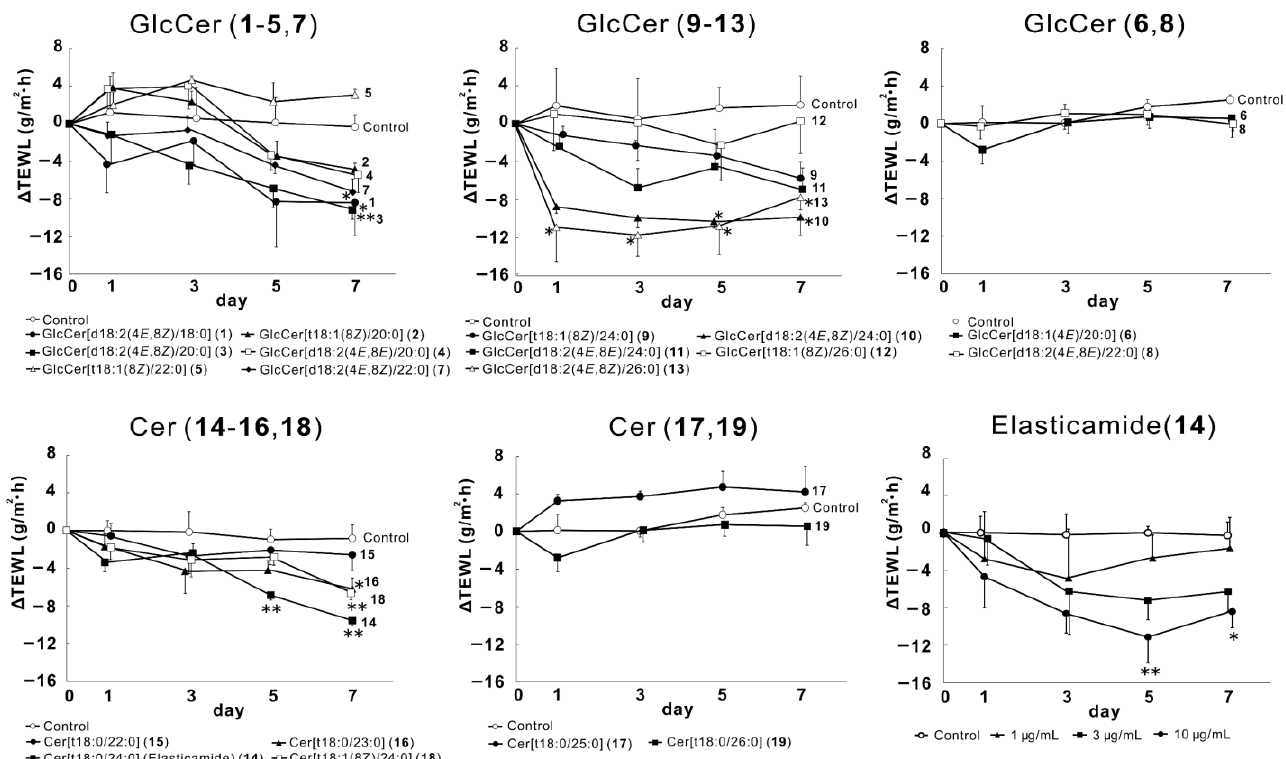
Figure 3. Effects of GlcCer ( 1 – 13 ) and Cer ( 14 – 19 ) on TEWL in the RHEK model. The RHEK model was treated for 7 days with each sample ( 1 – 13 : 10 µM, 14 : 1 – 10 µg/mL, 15 – 19 : 10 µg/mL). TEWL measurements were performed on days 0, 1, 3, 5, and 7 using Tewitro TW24. Data are expressed as means ± S.E. (n = 3 – 4). Asterisks denote a significant difference from the control group, * p < 0.05, ** p < 0.01.